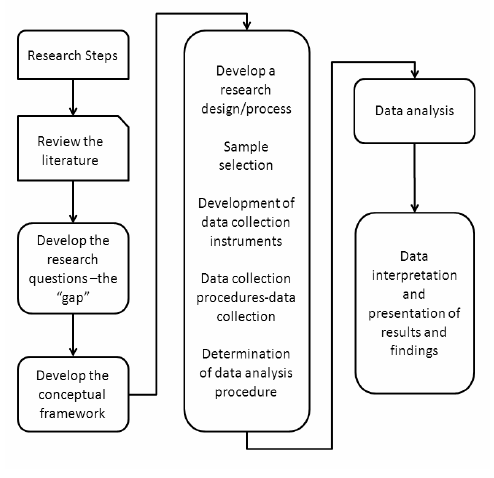
Figure 1. Routes along the capstone research stages.